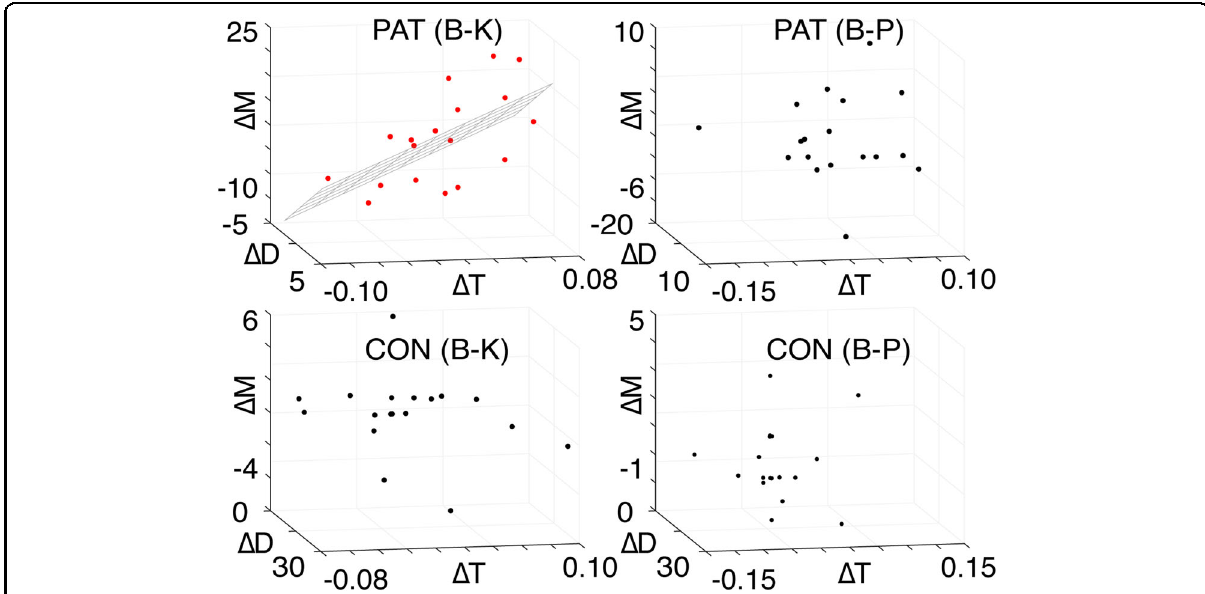
Fig. 4 MADRS scores and the Poincaré diagram. The changes in the trace ( Δ T ) and determinant ( Δ D ) from baseline to ketamine (B-K, fi rst column) and baseline to placebo (B-P, second column) for patients (PAT, fi rst row) and controls (CON, second row), as a function of the associated change in MADRS ( Δ M ) score. The hyperplane of the multiple linear regression is shown for the only signi fi cant model, PAT (B-K), with data points in